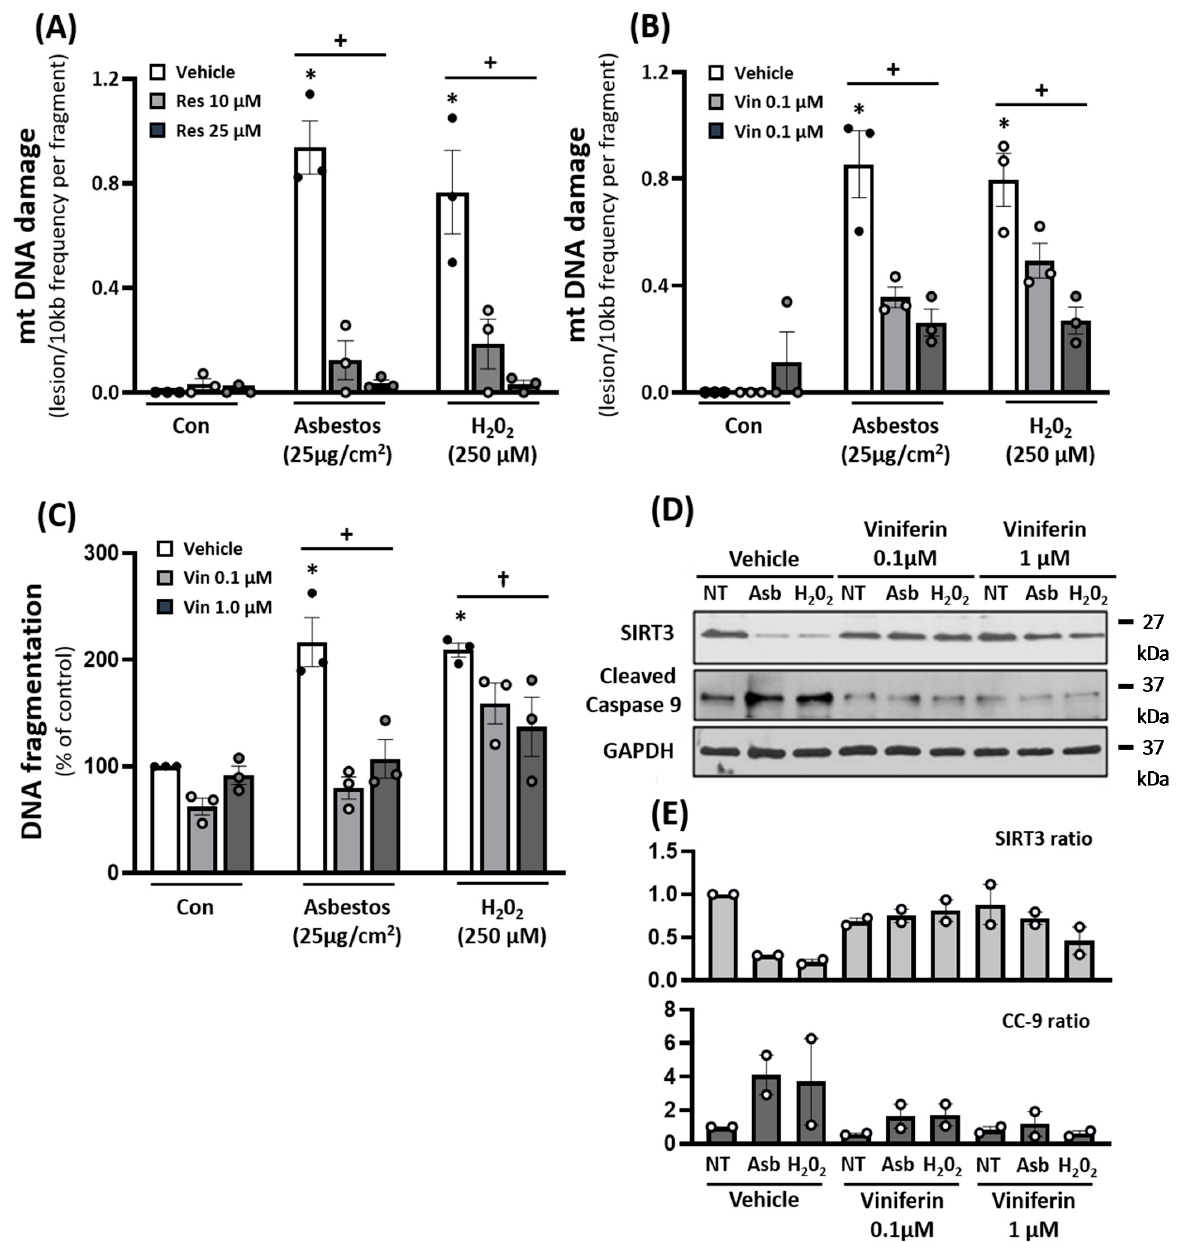
Figure 4. The SIRT3 agonists resveratrol and viniferin reduced oxidant-induced mtDNA damage, preserved SIRT3 expression, and reduced apoptosis in human AEC, as assessed by DNA fragmentation and CC-9 expression. A549 cells were pre-treated with resveratrol (10–25 µM) or viniferin (0.1–1 µM) for 6 h then exposed to either amosite asbestos (25 µg/cm 2 ) or H 2 O 2 , (250 µM), and 24 h later the cells were harvested for mtDNA damage, DNA fragmentation, or Western blotting. Resveratrol ( A ) and viniferin ( B ) mitigate oxidant-induced mtDNA damage. Viniferin ameliorates oxidant-induced apoptosis as assessed by DNA fragmentation ( C ) and cleaved caspase-9 ( D , E ) and preserved SIRT3 expression ( D , E ). For ( A – D ), n = 3, for E, n = 2; * p < 0.05 vs. vehicle, + p < 0.05 vs. vehicle, † p = 0.07 vs.